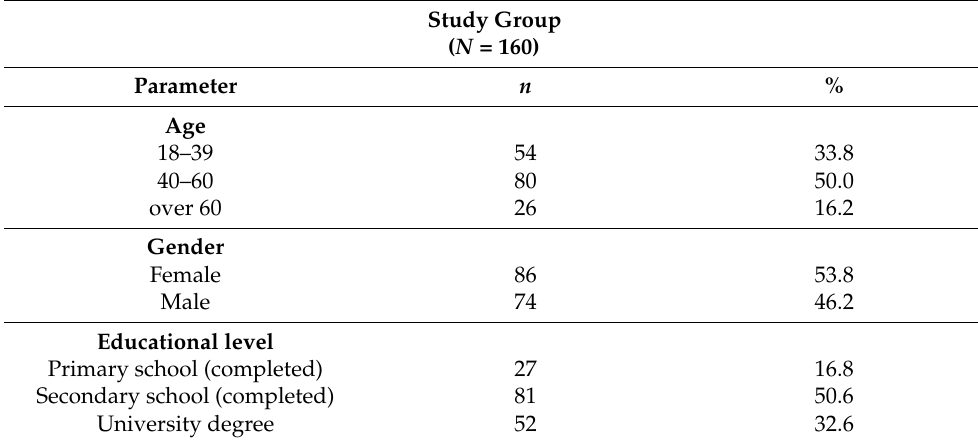
Table 2. Respondent characteristics: age, gender, and educational levels.